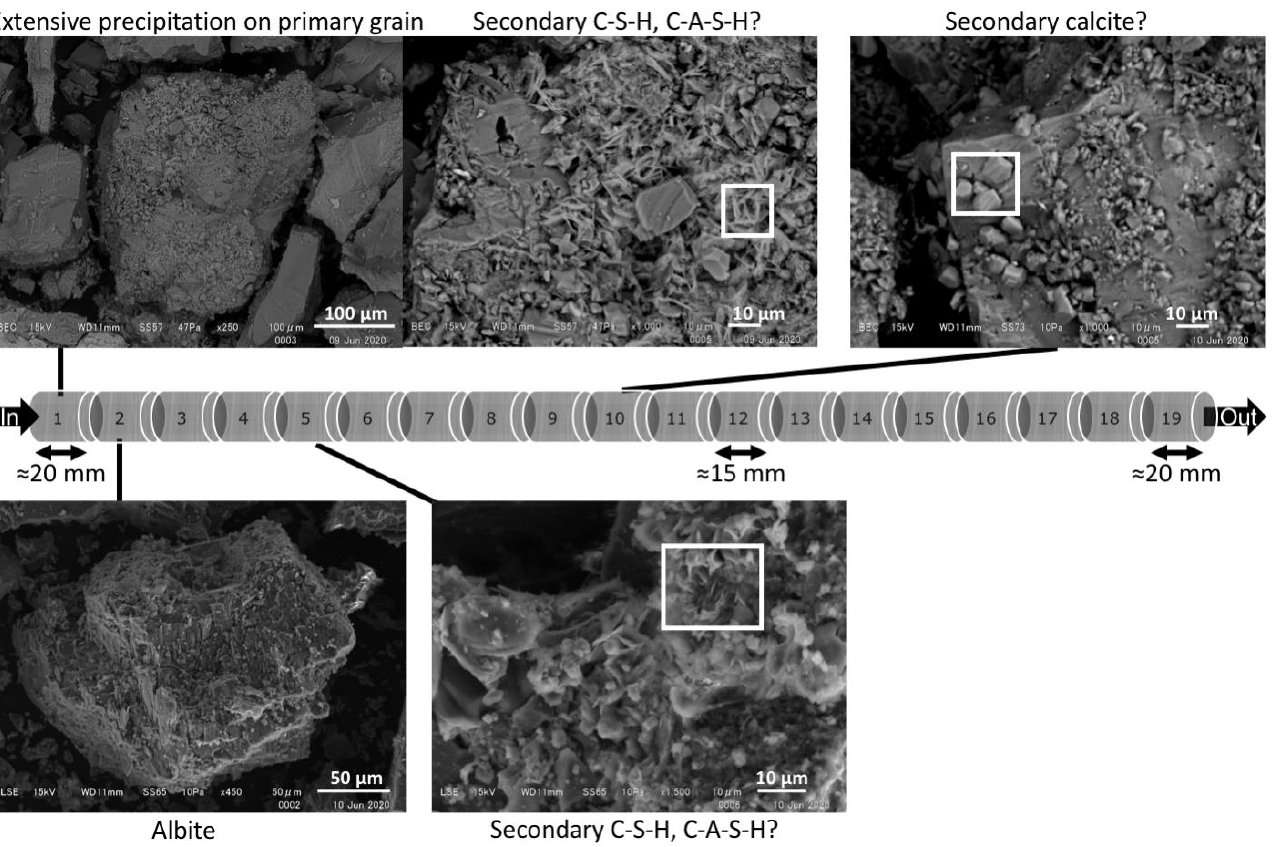
Figure 7. Summary of the mineralogy of the Toki granite with ‘young’ OPC, and then the ‘evolved OPC leachate (Col-2). SEM photos from Sections 2 and 5 are secondary electron (SE) images; others are backscattered electron (BSE) images. The white rectangles in the SEM images indicate the areas used for SEM – EDS analysis (see Figure S3b – d).